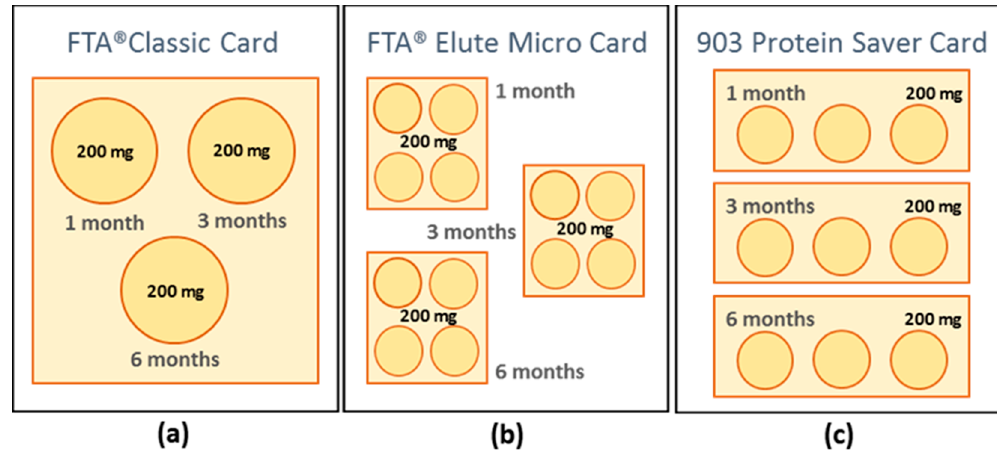
Figure 1. Standardisation of sampling areas for each Whatman ® card used in the present study to assess storage periods and conditions of impregnated stool samples ( a ) FTA ® Classic Card; ( b ) FTA ® Elute Micro Card; ( c ) 903 Protein Saver Card.